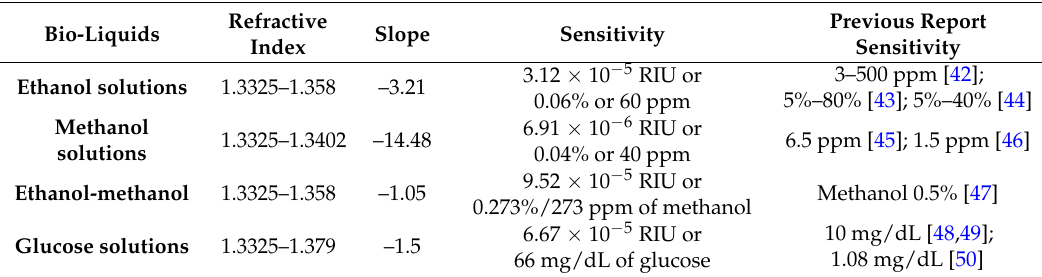
Figure 7. The maximum intensities as a function of the refractive index for ( a ) ethanol solutions; ( b ) methanol solutions; ( c ) ethanol-methanol solutions; and ( d ) glucose solutions. In each panel, the slope ∆ A / ∆ n was derived by linearly fitting all points. Table 1. The slopes and sensitivities for different bio-liquids.